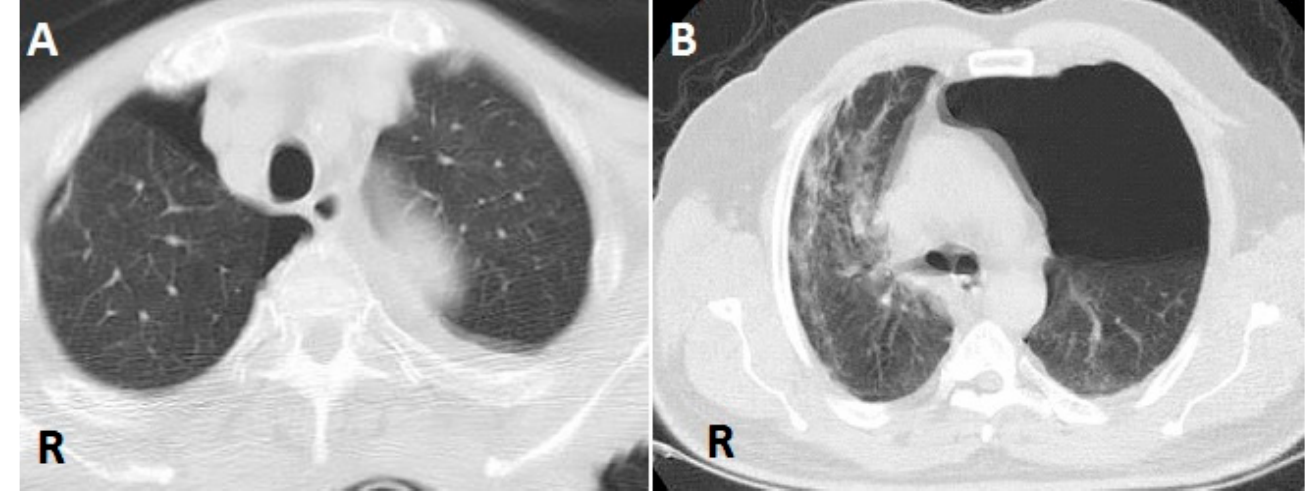
Figure 1. ( A ) Air is seen in the right pleural space due to pneumothorax (PNX) on axial thoracic CT scan. ( B ) Air is seen in the left pleural space due to PNX on axial thoracic CT scan(R: right).